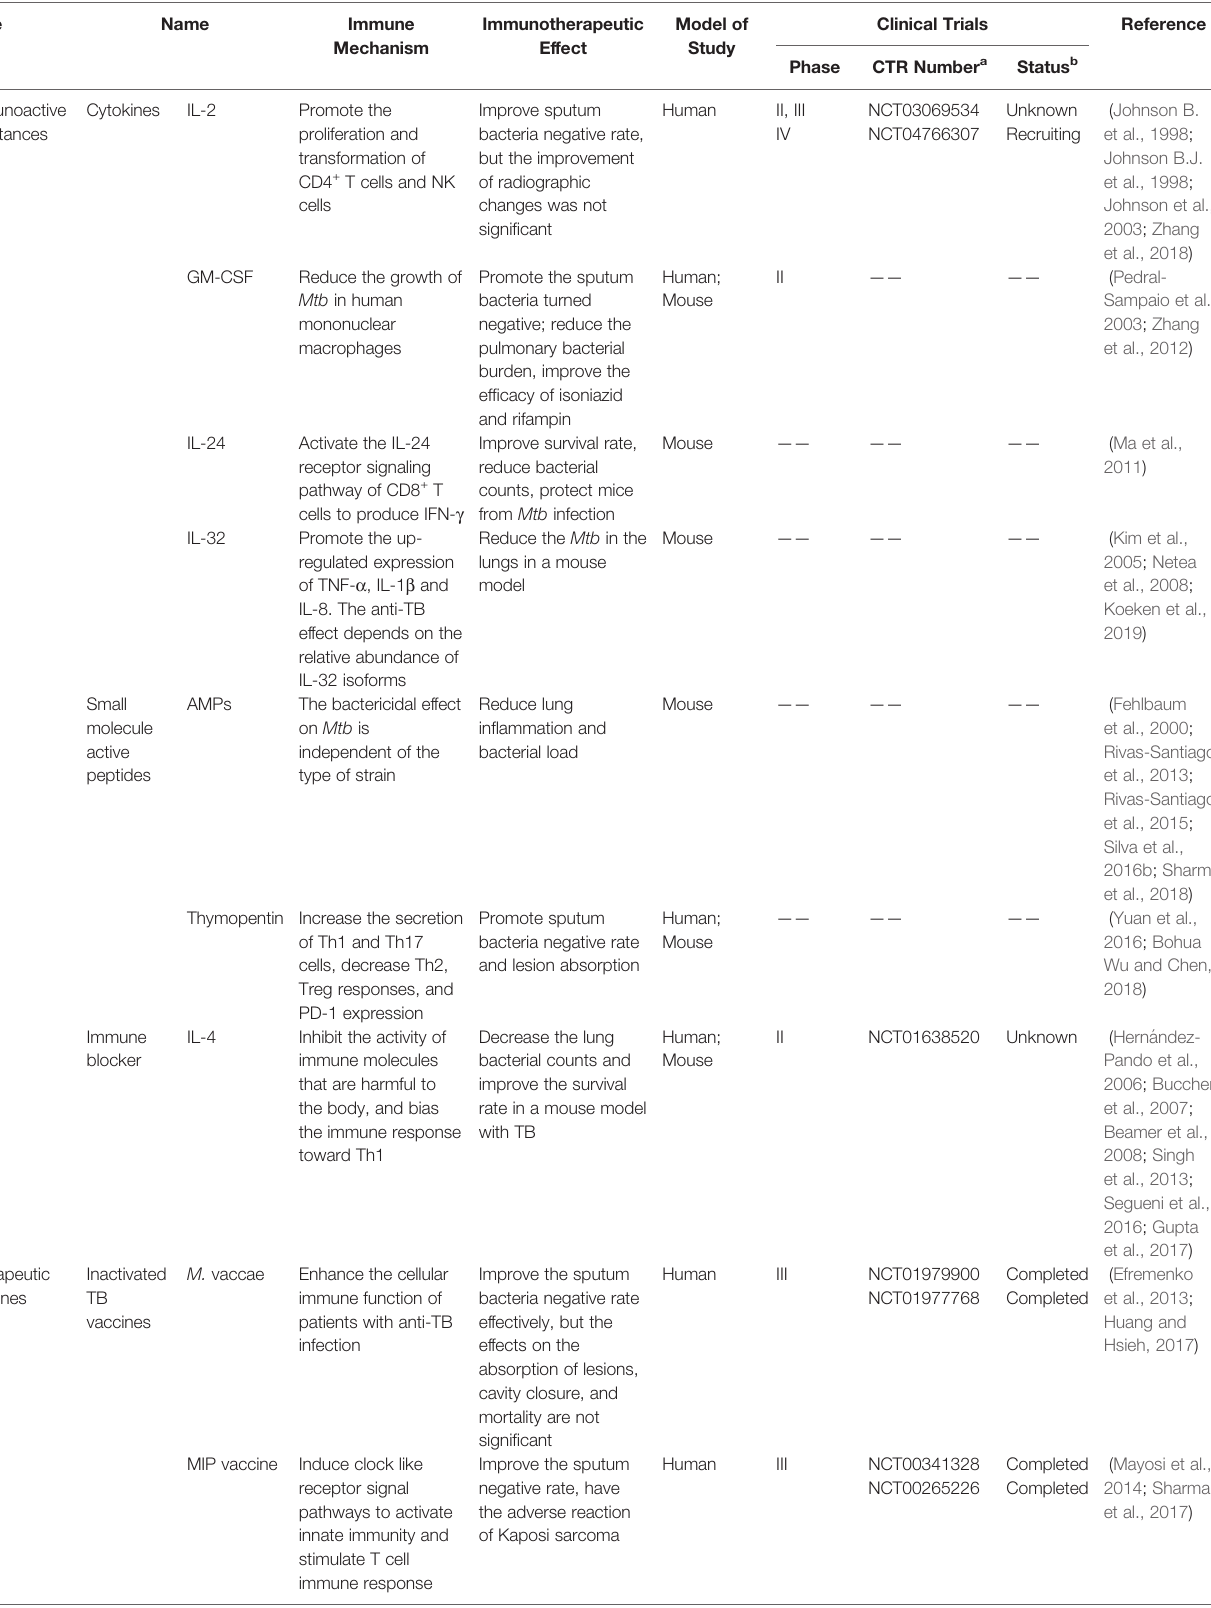
TABLE 1 | Summary of the development of immunoactive substances, vaccines, chemical agents, and cellular